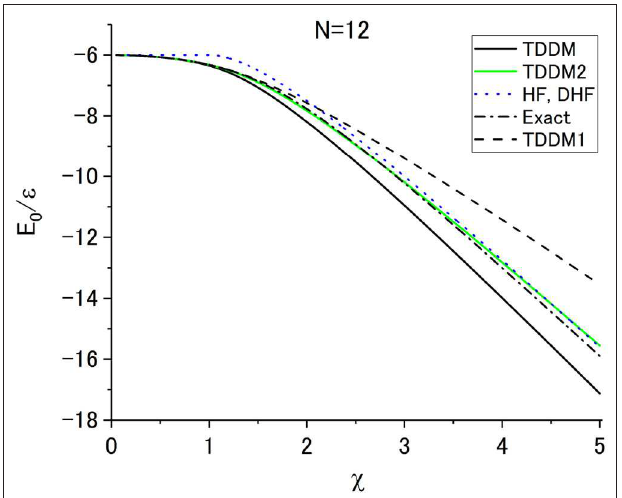
FIGURE 1 | Ground-state energy in TDDM (solid line) as a function of V χ ( N 1) /ǫ for N 12. The results in TDDM1 where the three-body = | | − = correlation matrix is given by Equations (10) and (11) are shown with the dashed line. The green (gray) line depicts the results in TDDM2 where the three-body correlation matrix is given by Equations (12) and (13). The results in HF and DHF( χ > 1) are depicted with the dotted line. The exact values are given by the dot-dashed line. Adapted from Tohyama and Schuck [45] with permission from Societ a Italiana di Fisica/Springer-Verlag GmbH Germany. `